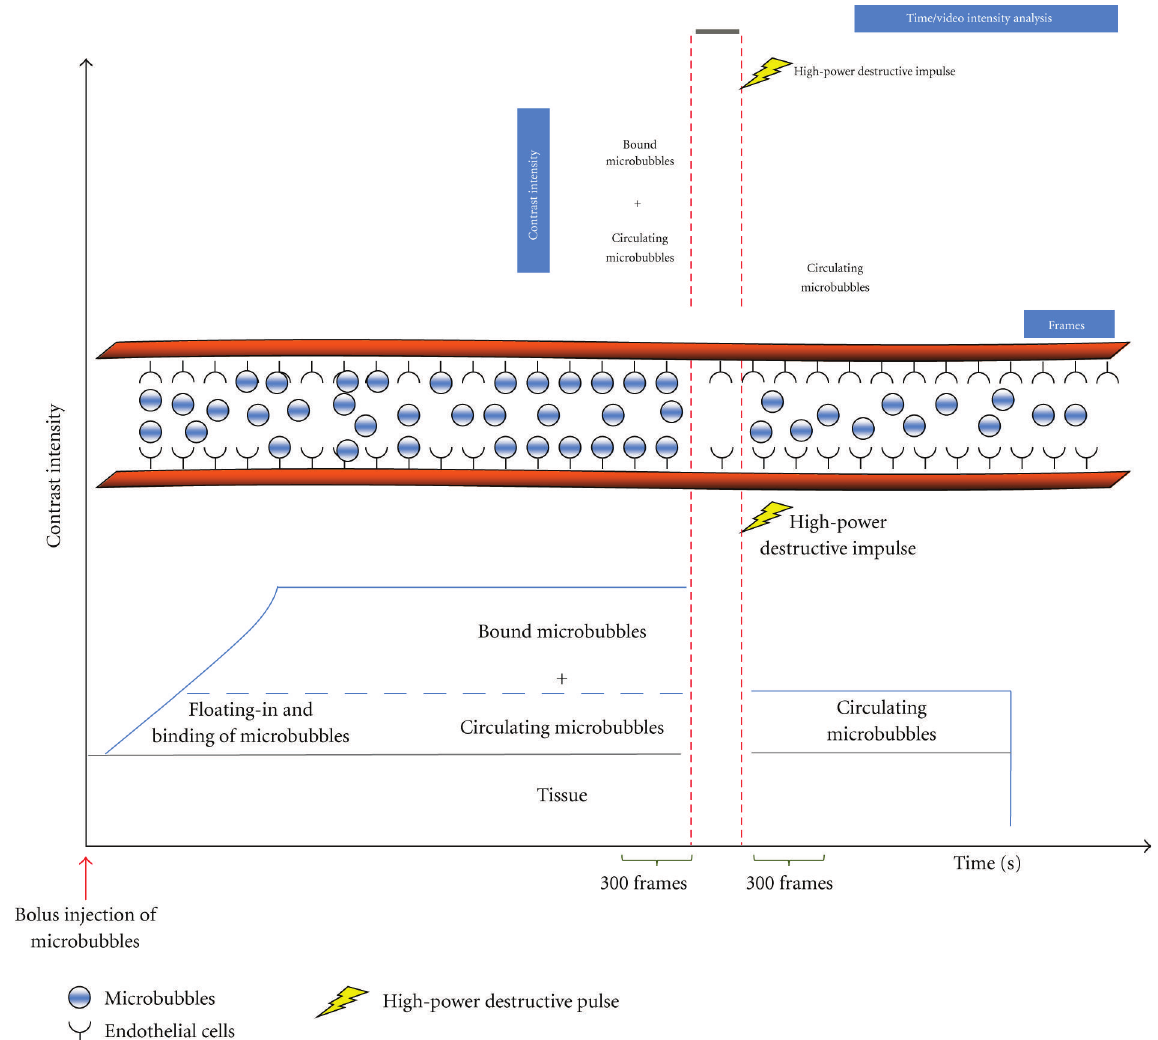
Figure 5: Targeted US of endothelial antigens in vessels of a tumor tissue. On the top of the figure time/video intensity analysis before and after high-power destructive pulse and bottom a diagram representation of destructive methodology. Endothelial cells of vessels (orange) of tumor tissues expresses specific antigens. After intravenous administration targeted microbubbles float in vessels and remaining exclusively in the vascular compartment. Many of them bind to antigens of endothelial cells , whereas others remains in the vessel lumen freely circulating. After high-power destructive pulse, all microbubbles are destroyed (bound + circulating), following circulating microbubbles that arrive from outside of scan plane, which remain freely circulating for several seconds. Contrast intensity is the sum of the intensity from tissue, intensity from microbubbles not bound to receptors (circulating microbubbles), and intensity from microbubbles bound to receptors on endothelial cells. After digital subtraction of the video intensity calculated on 300 predestruction frames from video intensity calculated on 300 postdestruction frames, resulting video intensity is due only to bound